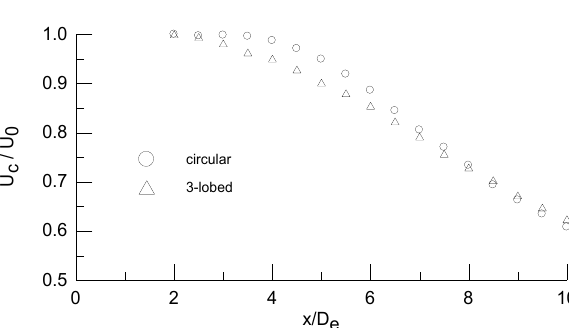
Fig. 9. Streamwise velocity decay along the jet